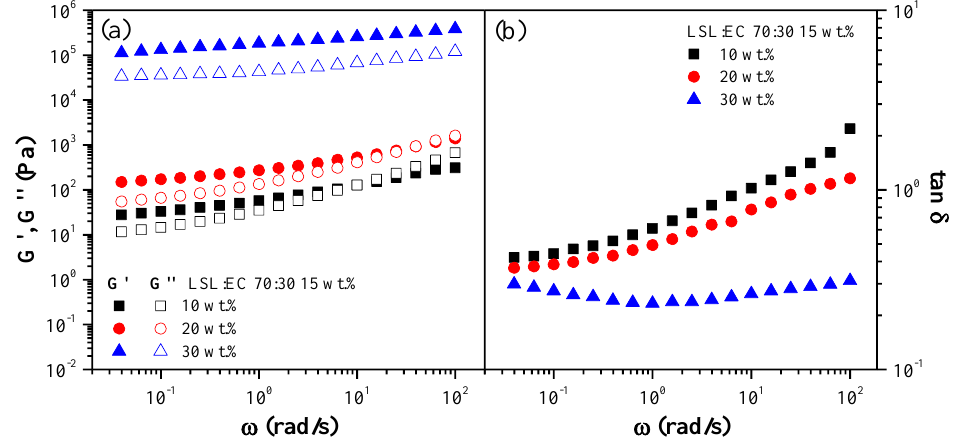
Polymers 2022 , 14 , x FOR PEER REVIEW